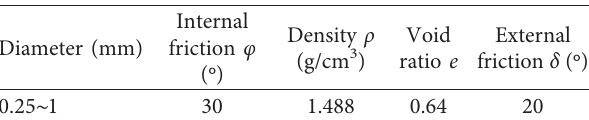
Figure 3: Schematic diagram of GeoPIV. (a) Initial image. (b) Deformed image. Table 1: Soil